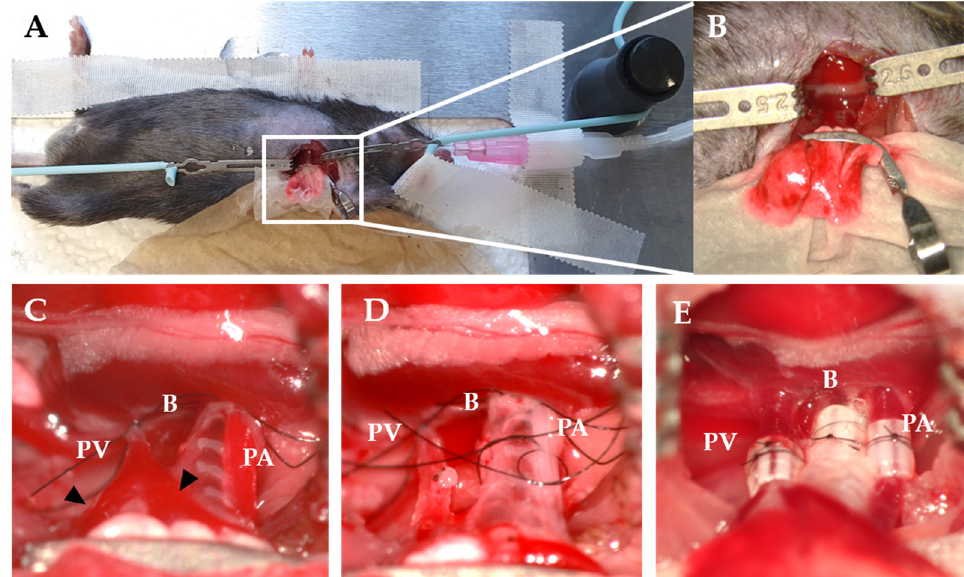
Figure 2. Recipient procedure in mice LTx. ( A ) Right decubitus position of recipient. ( B ) The hilum is exposed using a curved micro serrefine. ( C ) Occlusion of PV and PA using a slipknot. Triangles indicate the branches of the PV. ( D ) B and PA are ligated with a circumferential suture. ( E ) Cuffs after implantation and reperfusion. PV—pulmonary vein; B—bronchus; PA—pulmonary artery.